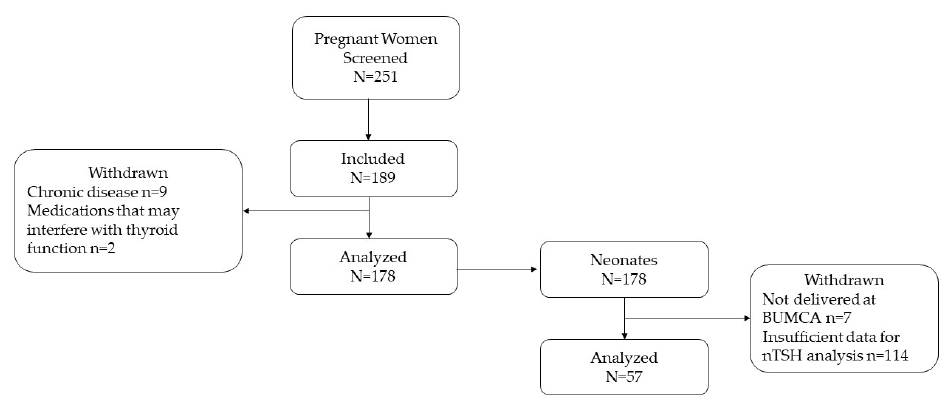
Figure 1. Study flow chart. Abbreviations: BUMCA = Barzilai University Medical Center, Ashkelon, nTSH = neonatal thyrotropin.